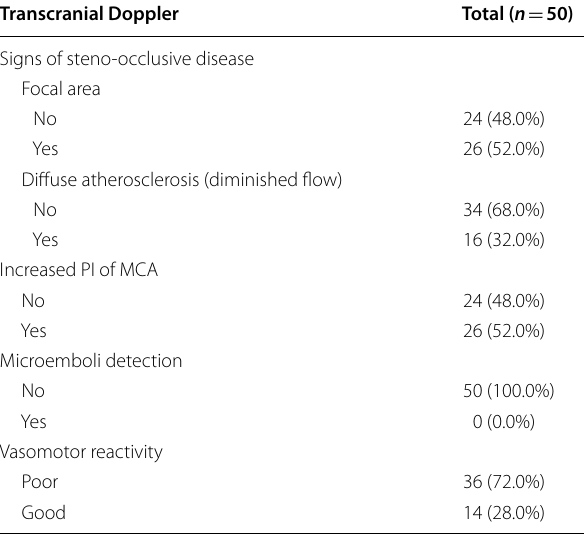
Table 3 Transcranial Doppler findings distribution of the study group